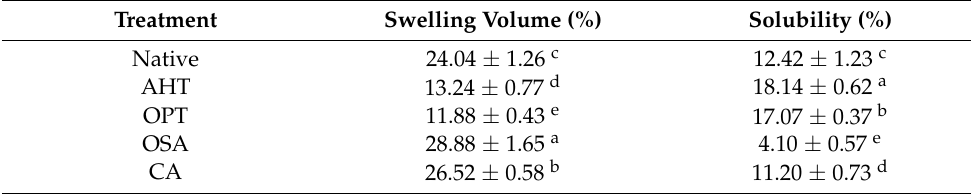
Table 4. Swelling volume and solubility of native and modified sago